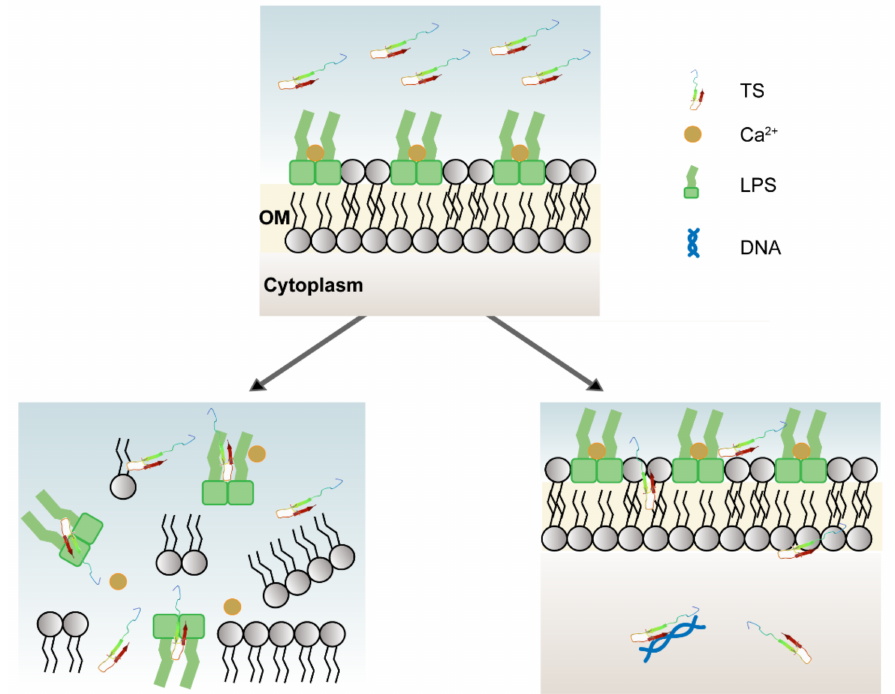
Figure 7. Multiple mechanisms of antimicrobial peptide TS. TS can inhibit and kill bacteria by dis- placing divalent cations, competitively binding lipopolysaccharides, and from within by interacting with bacterial